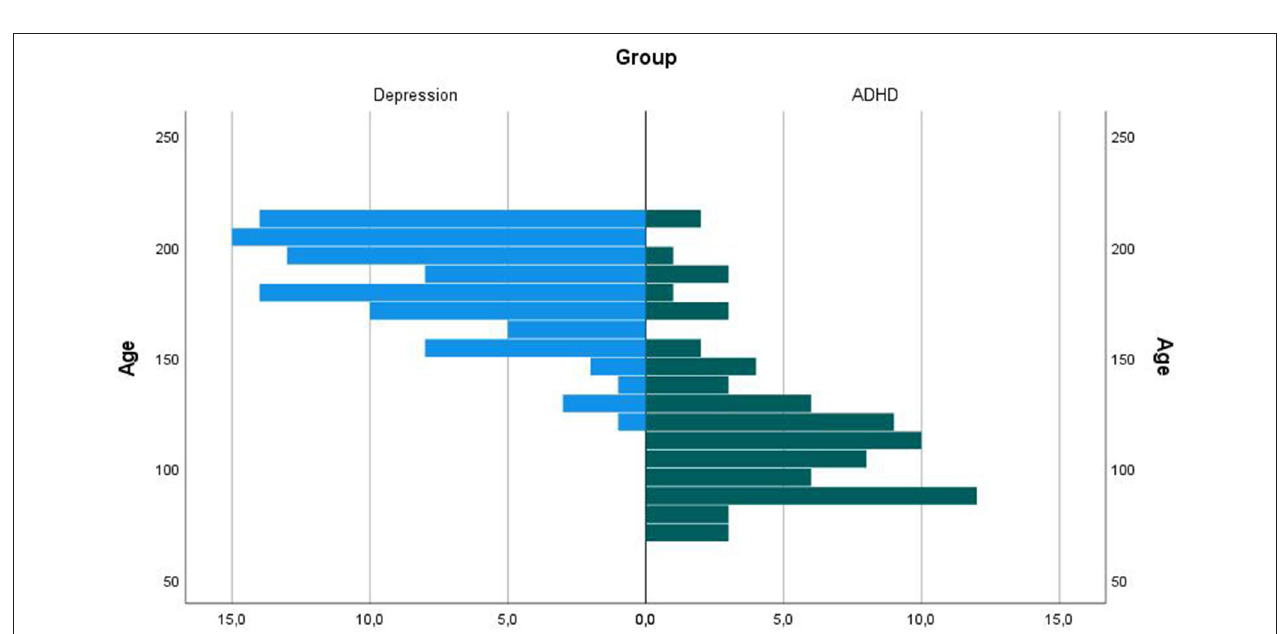
76 (ADHD), N 94 (Depression). As can be seen, the ages are = =